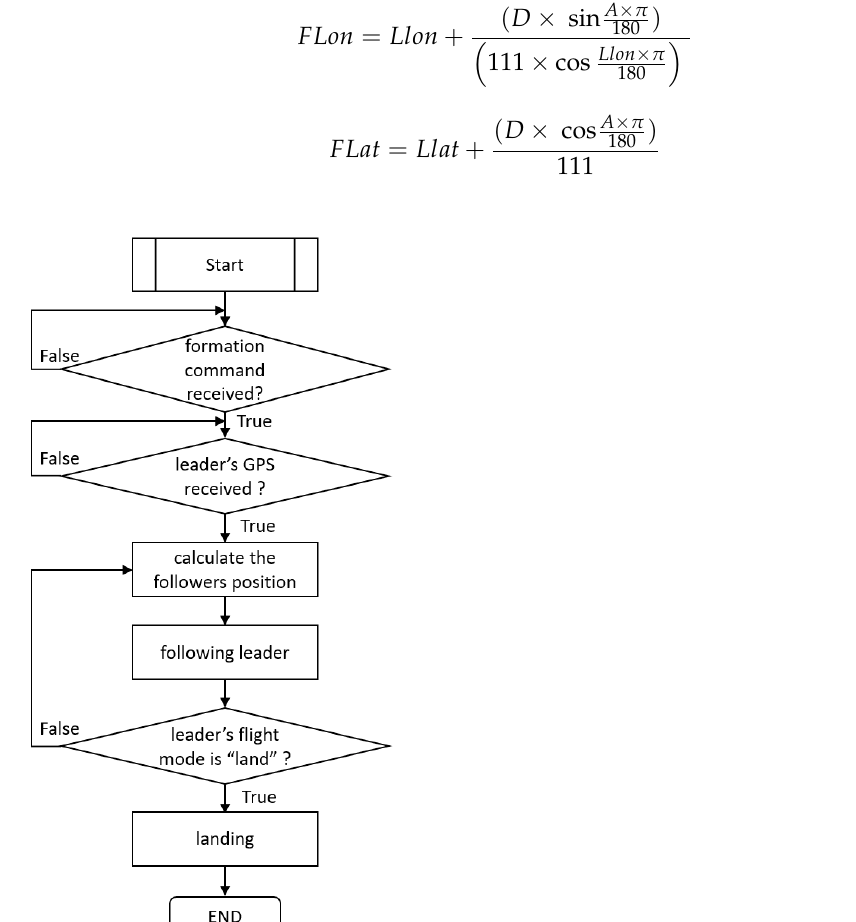
Figure 4. Formation control flow chart.